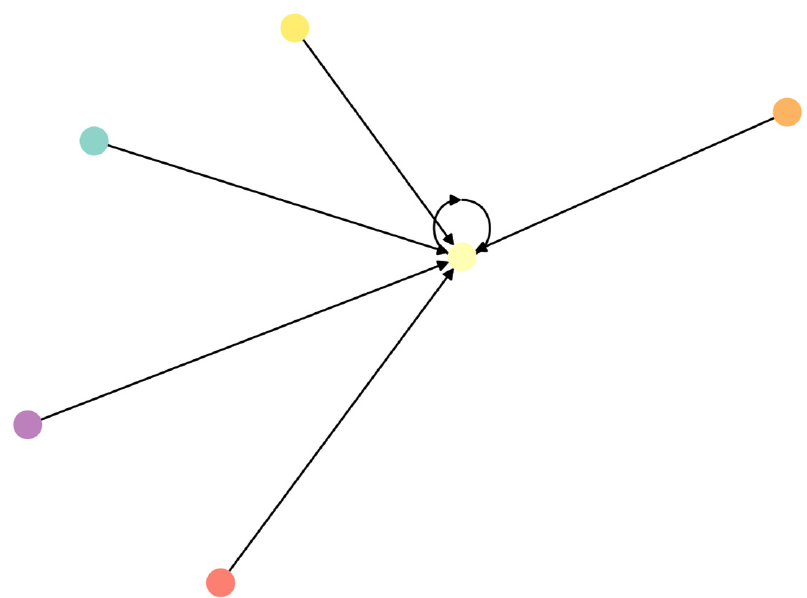
Figure 3. Example of logic representation for the graph topology.